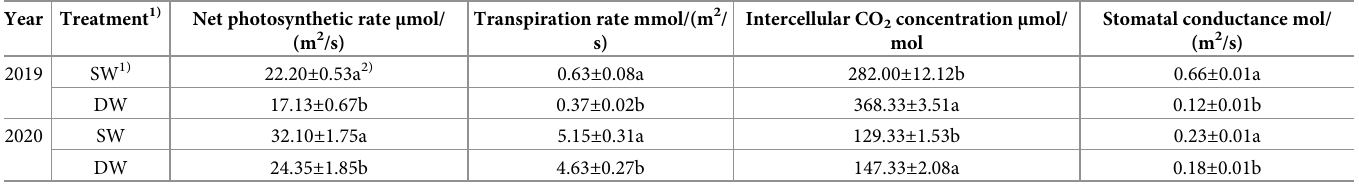
Table 3. Effects of different treatments on maize photosynthesis.